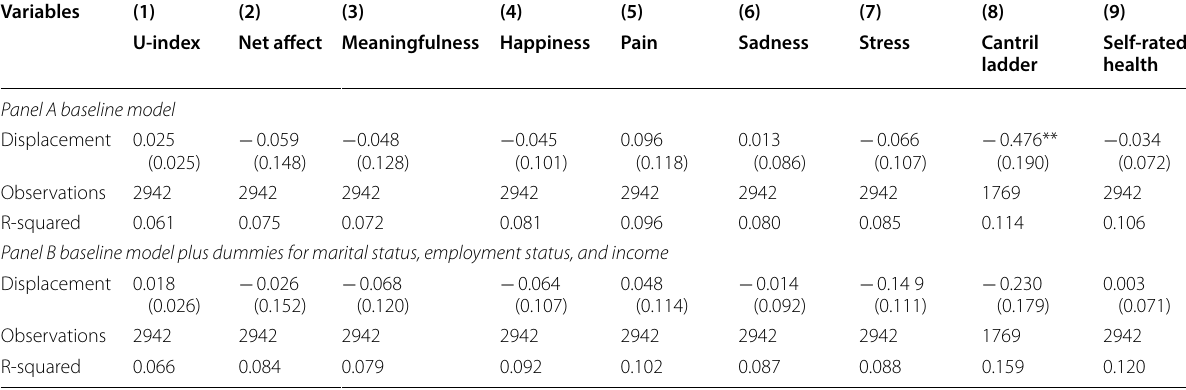
The estimates in columns 1 through 7 and 9 are OLS coefficients from the 2010, 2012, and 2013 ATUS WB Modules; the estimates in column 8 are OLS coefficients from the 2012 and 2013 ATUS WB Modules. All estimates use the WB Module final weight (WUFINLWGT). Standard errors in parentheses. *** p < 0.01, ** p < 0.05, * p < 0.1. The following control variables are included in all columns in both Panels A and B: age and its square; three dummies for race/ethnicity; five education dummies; number of disabilities; an immigrant dummy; number of children; a metropolitan status dummy; two season dummies; year dummies; dummies for the DWS year; and state dummies. Columns 1 through 7 additionally contain a holiday dummy and six dummies for the days of the week. Panel B additionally includes two marital-status dummies; two employment-status dummies; and four dummies for family income during the last 12 months Table 3 Coefficients on job displacement in the subjective well-being regressions: women